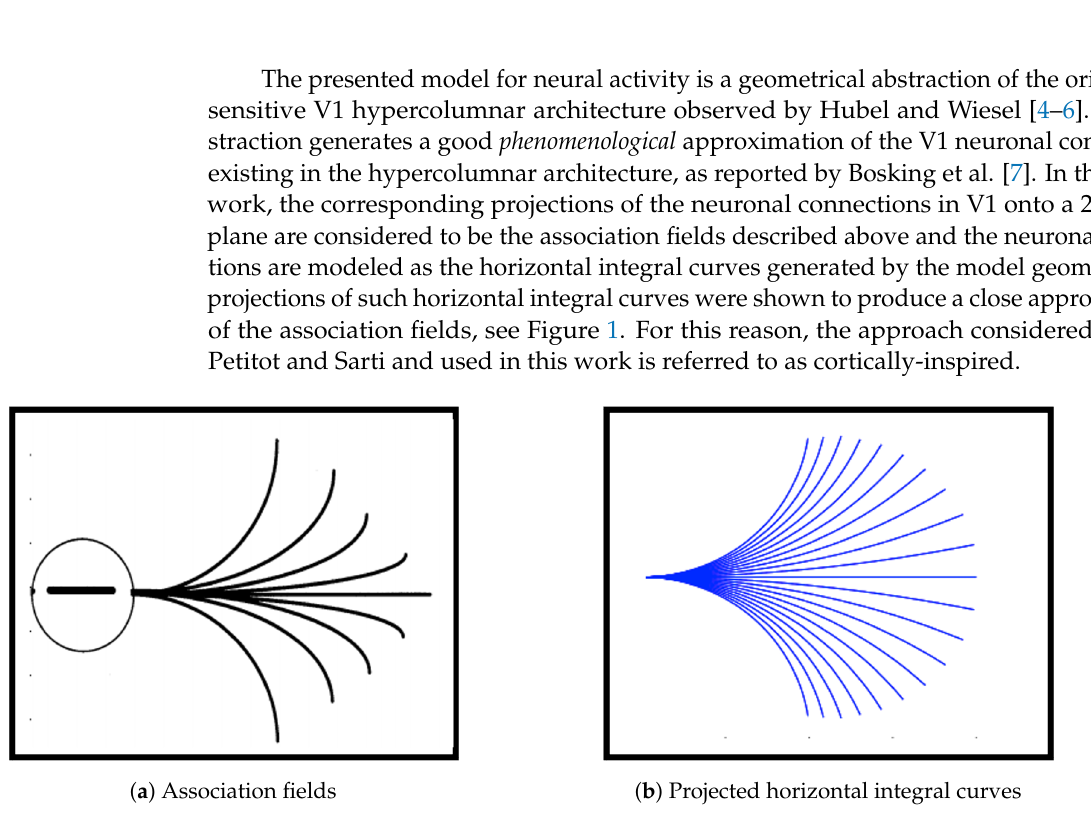
Figure 1. Projections of horizontal integral curves approximate the association fields from the experiment of Field, Hayes and Hess [3]. They are generated by the sub-Riemannian model geometry proposed by Citti and Sarti [8]. Figures are adapted from